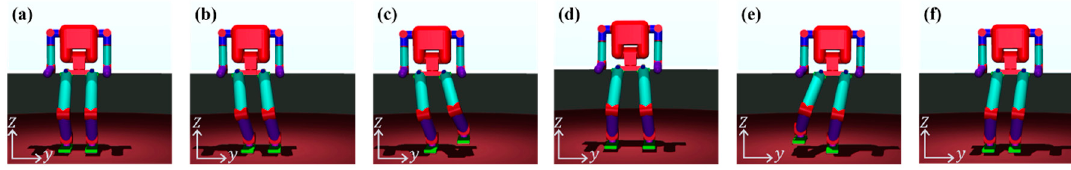
Figure 3. Sideways walking. ( a ) Initial position, ( b ) moving zero-moment point above the right foot, ( c ) left foot lifting, ( d ) left foot lowering after swing, ( e ) moving zero-moment point above the left foot and right foot lifting, ( f ) right foot lowering and motion